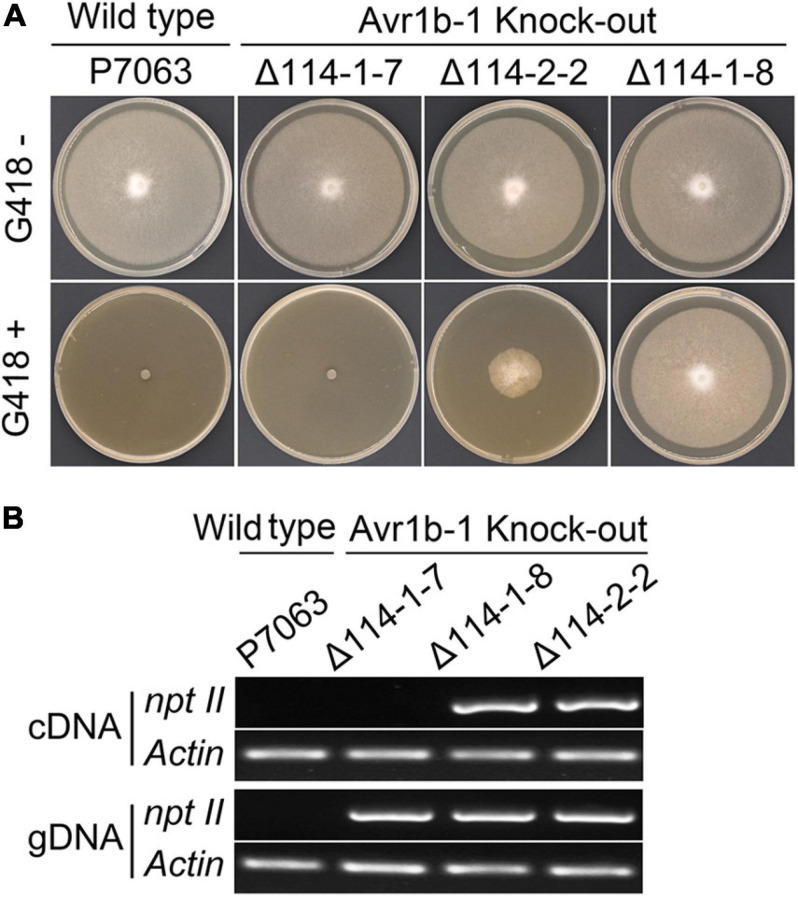
G418 sensitivity of Avr1b-1 knock-out transformants. (A) Wild-type P7063 and three selected Avr1b-1 deletion transformants cultured on clarified V8 medium with or without 50 μg/ml G418. Transformants Δ114-1-7 and Δ114-2-2 were isolated from G418 regeneration medium and then subcultured in V8 medium. Transformant Δ114-1-8 was maintained on V8 medium containing 50 μg/ml G418. (B) PCR detection of npt II sequences in genomic DNA and RNA of Avr1b-1 knock-out transformants and P7063 with primer pair qNptF/R. P. sojae Actin was used as the reference gene.